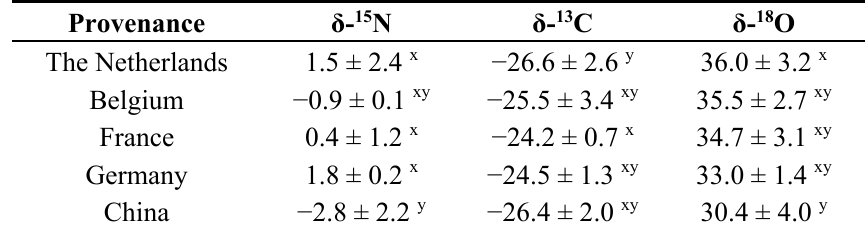
Table 1. Nitrogen, carbon and oxygen isotope ratio’s ( δ values, per mil) for C. majalis of various provenance a ; means ± SE.